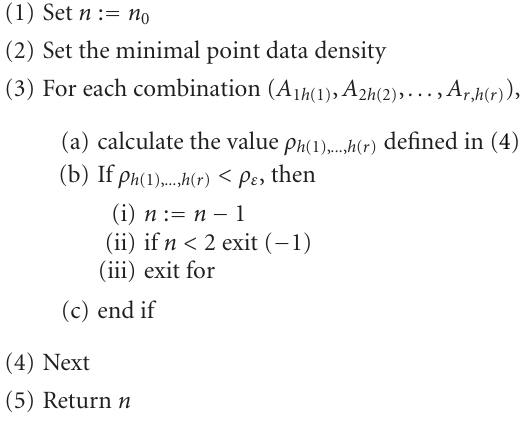
Figure 13: Inclusion areas for the fuzzy association rule R 2.